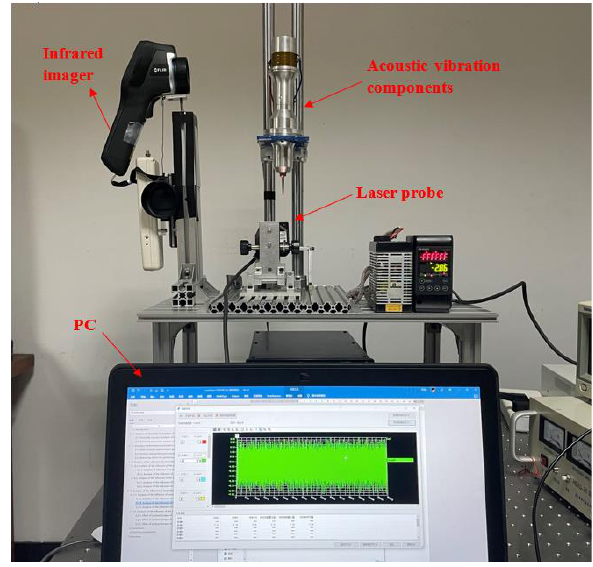
Figure 10. Infrared Temperature Measurement Experimental Device.